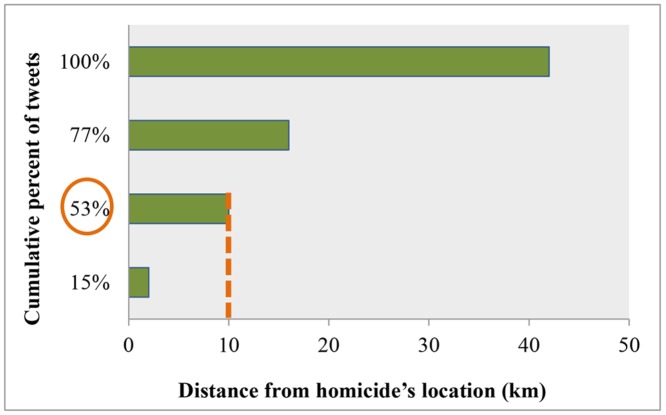
The cumulative percent of crime tweets at different distance intervals.Distance is defined as the distance from users’ estimated home locations to the crime incidents’ locations.